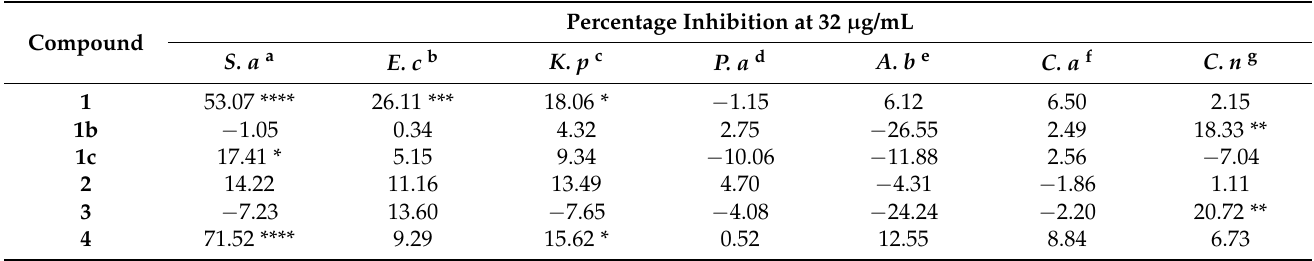
Table 3. Antimicrobial and antifungal activities of natural products 1 – 4 and derivatives 1b and 1c .